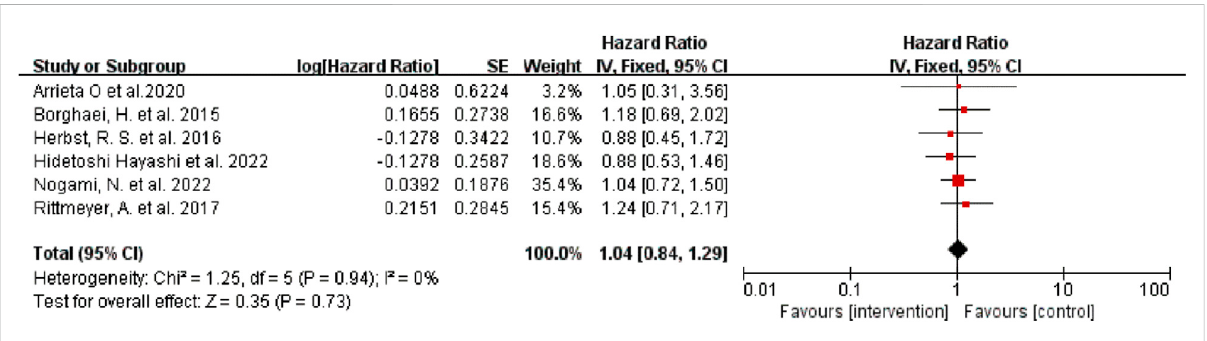
FIGURE 2 Forest Plot of Hazard Ratios Comparing OS in Patients Who Received Immune Checkpoint Inhibitors vs. Other